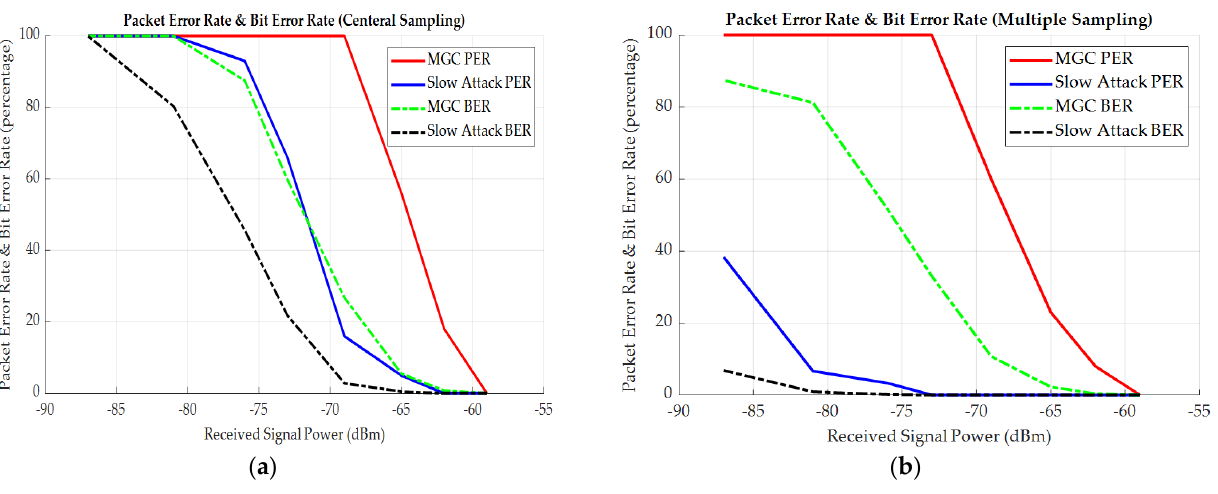
Figure 11. Packet error rate and the bit error rate of central sampling method ( a ), and multiple- sampling method ( b ).